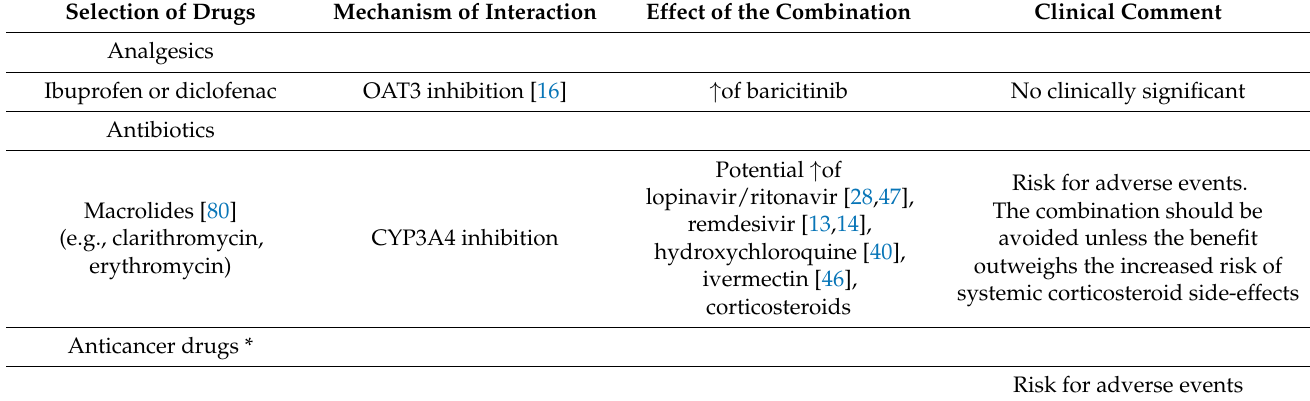
Table 5. COVID-19 drugs as victims of drug-drug